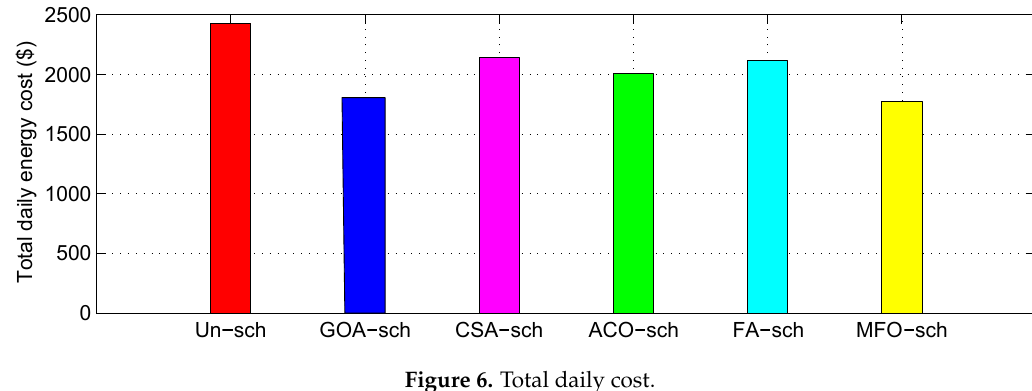
Figure 6. Total daily cost.